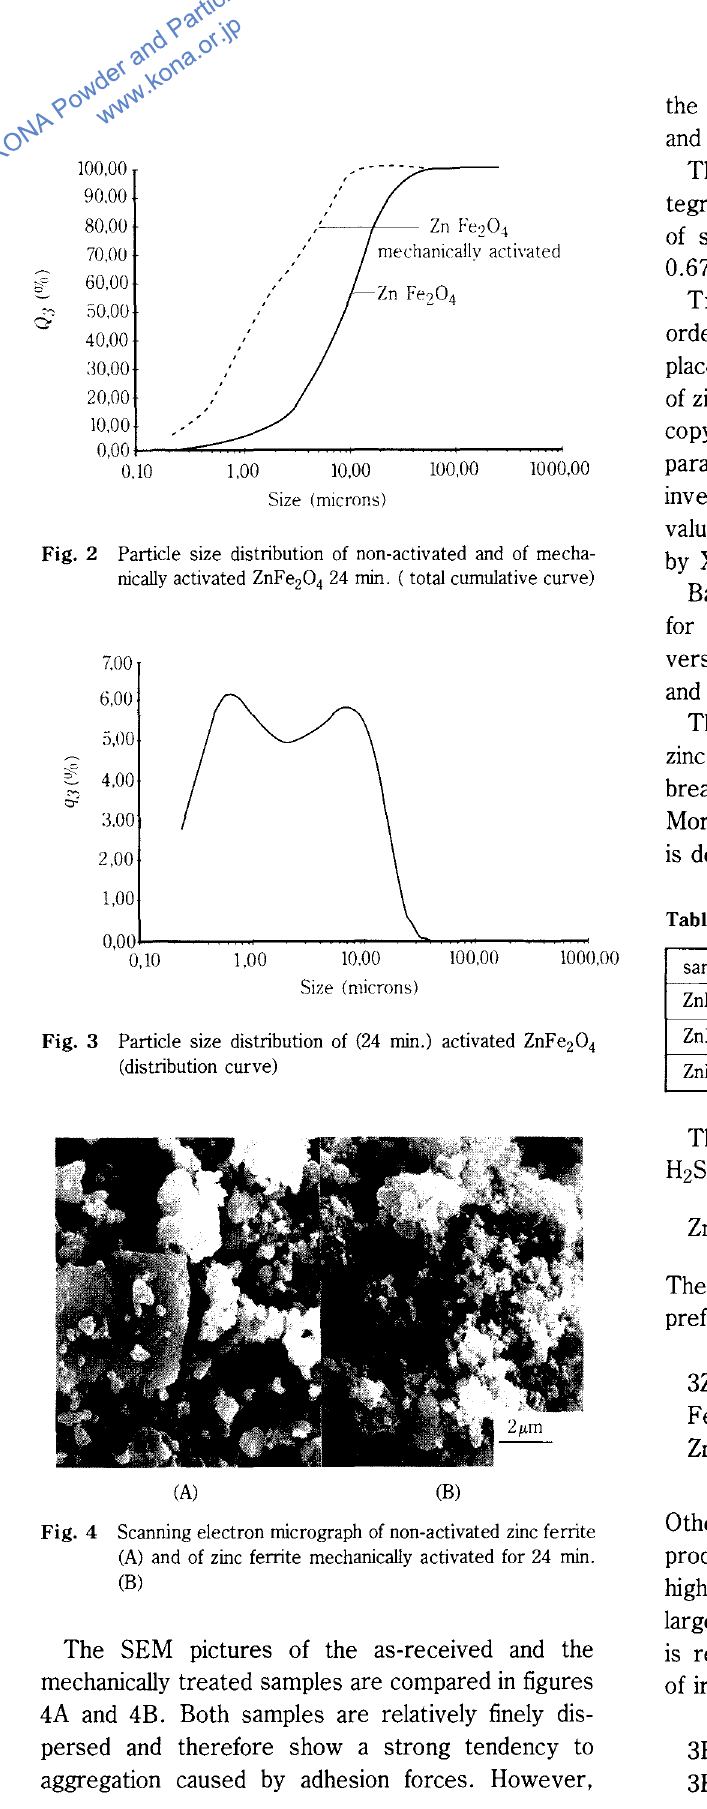
Fig. 4 Scanning electron micrograph of non-activated zinc ferrite (A) and of zinc ferrite mechanically activated for 24 min.